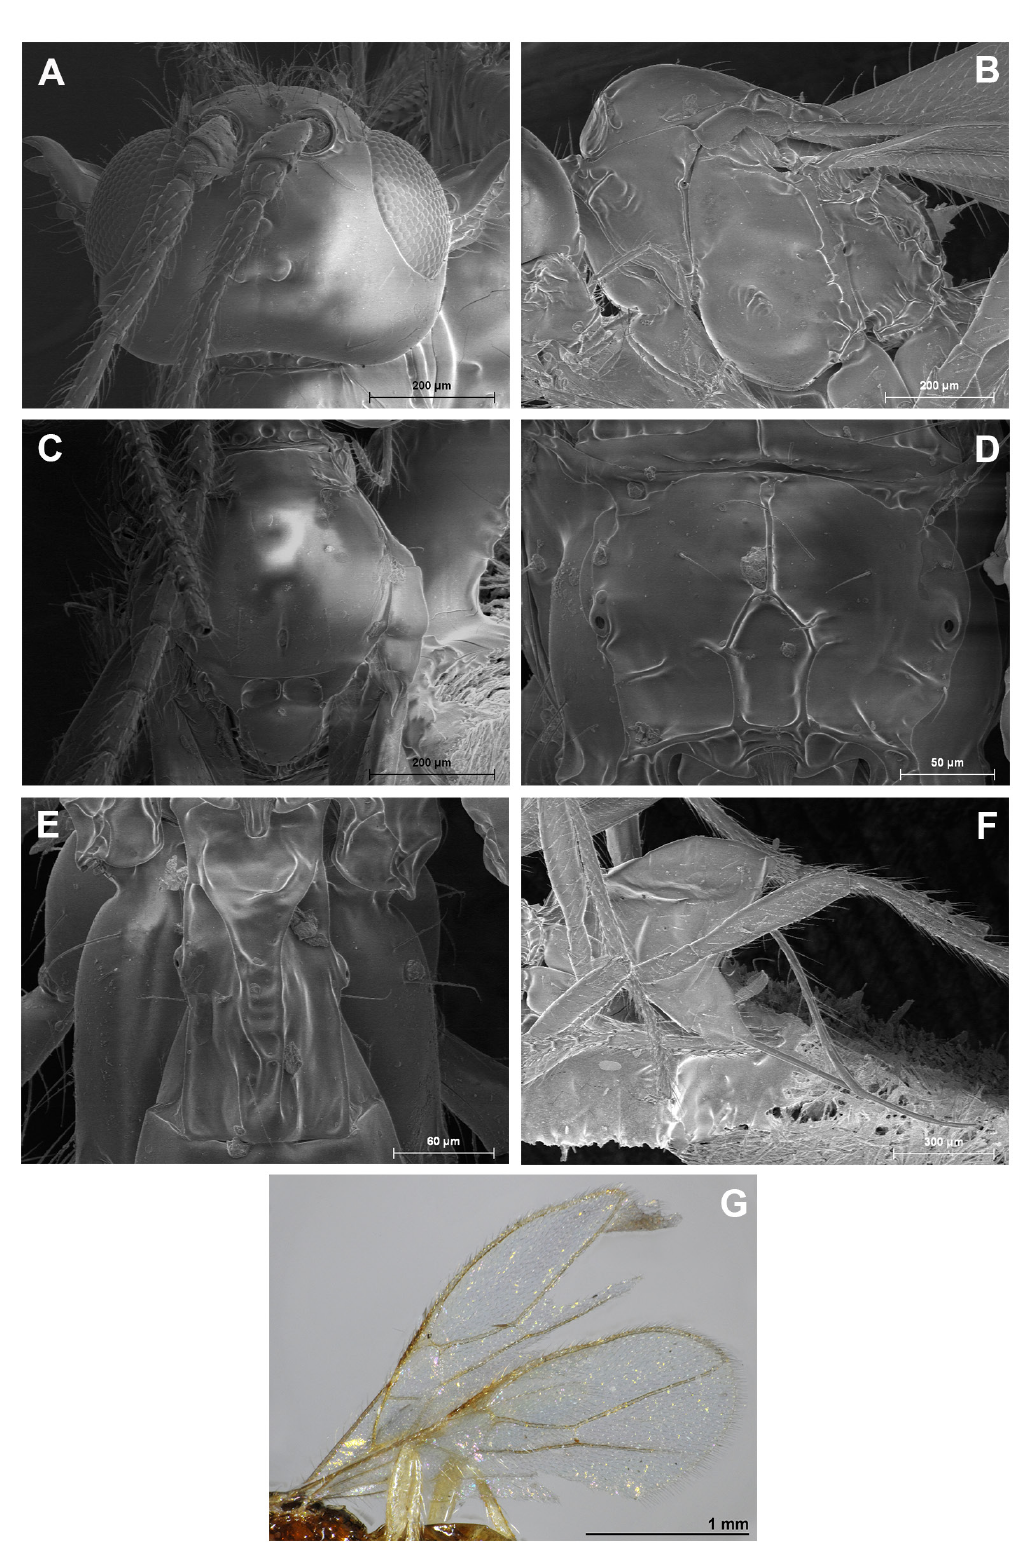
Fig. 22. Asobara glabrisulcata Fischer, 2003, ♀, holotype (NHMW). A . Head, dorsal view. B . Mesosoma, lateral view. C . Mesoscutum, dorsal view. D . Propodeum. E . First metasomal tergite, dorsal view. F . Hind leg, metasoma and ovipositor, lateral view. G . Fore and hind